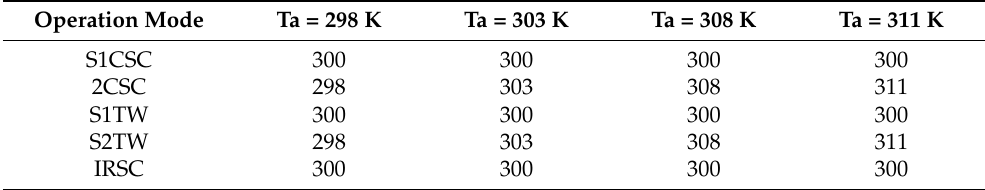
Table 4. The air temperature at the inlet under different operation modes in Nanjing in the summer. Operation Mode